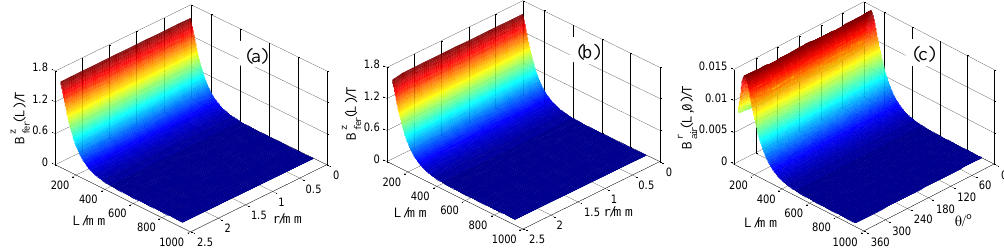
Figure 5. The distribution of B z in the cylindrical interface r = 2.5 mm ( c ) from L = 55 mm to L = 910 mm.